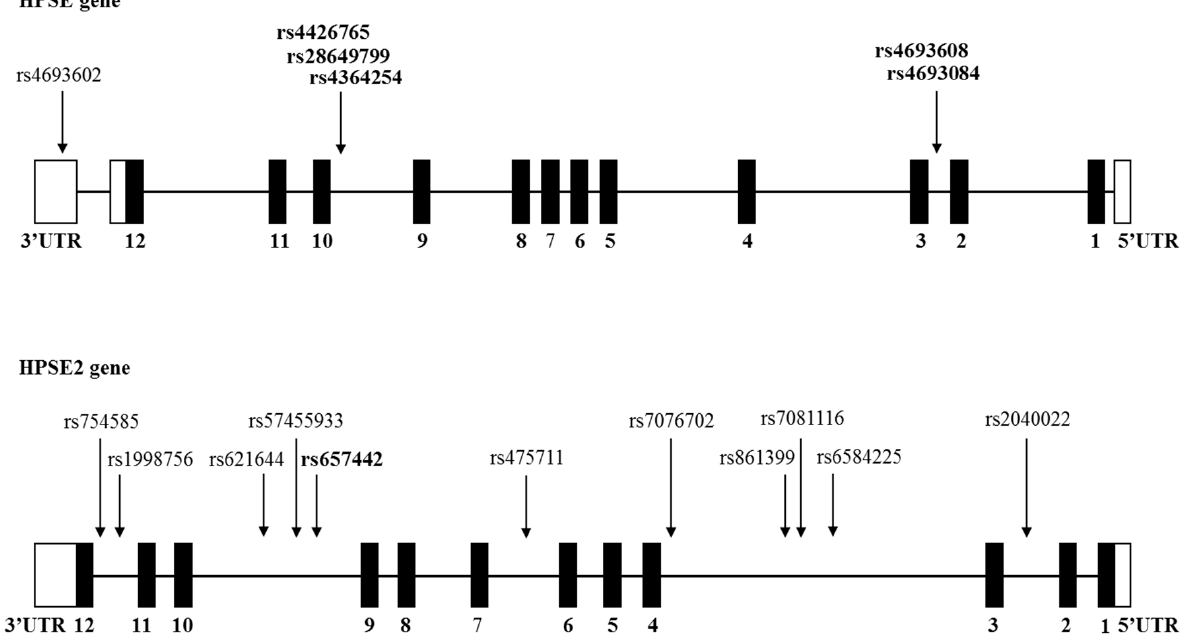
Figure 1. Map of the HPSE and HPSE2 genes. Numbered boxes indicate exons. Black boxes depict open reading frames, and white boxes represent the 5’- and 3’-untranslated regions. The most prominent SNPs are marked in bold in both genes. Arrows point to the location of SNPs.